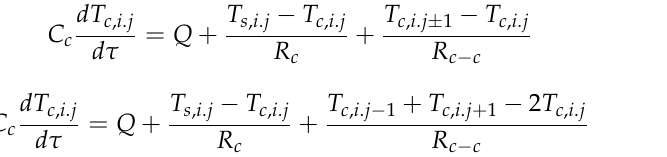
Figure 11. Proposed mathematical model for battery cells placed in horizontal position.